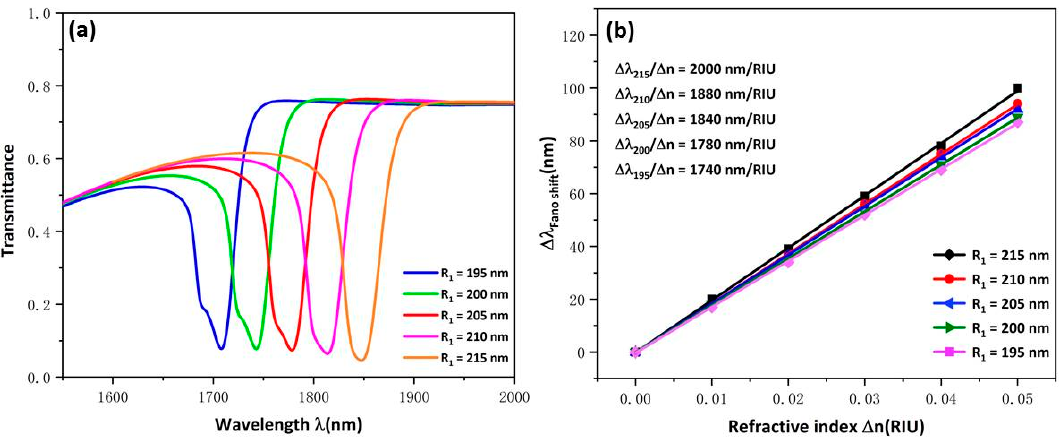
Figure 3. ( a ) Transmission spectra for USRR under various R 1 values; ( b ) Fitting lines of sensitivity at disparate values of R 1 .